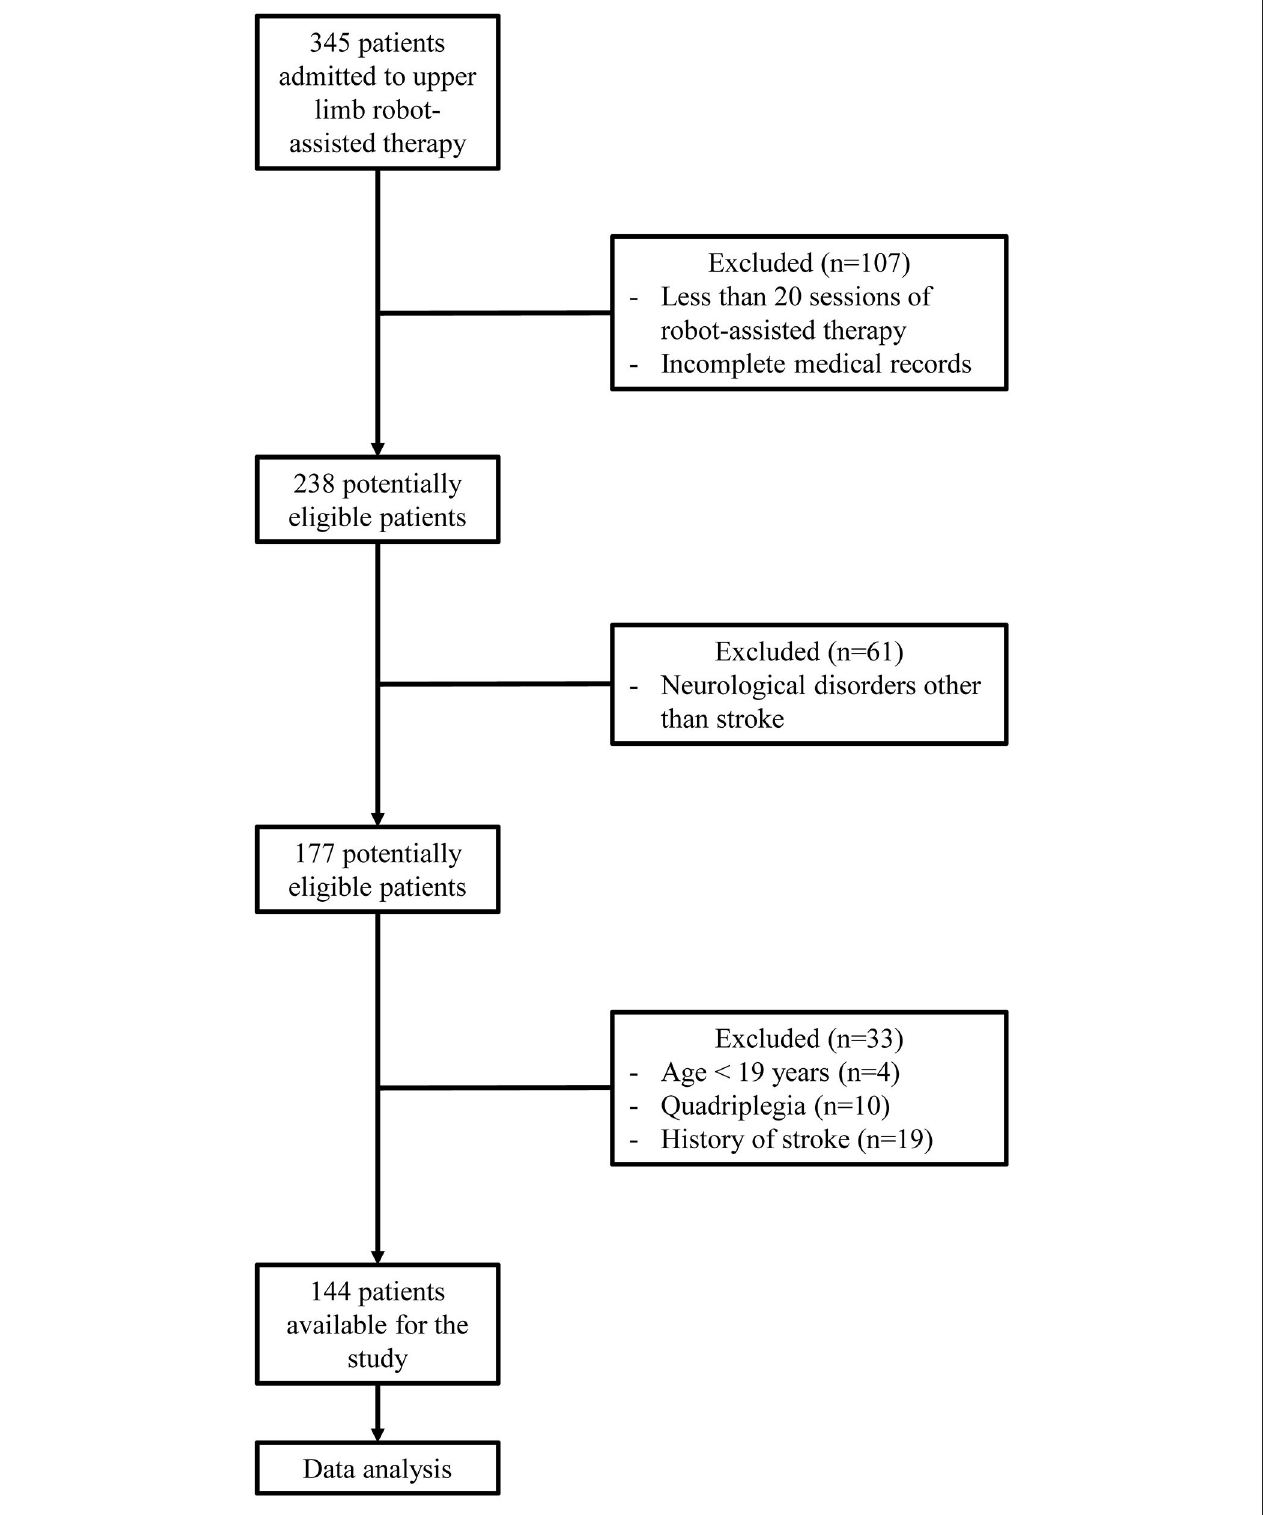
FIGURE 1 | Flow diagram of the selection procedures of stroke patients.